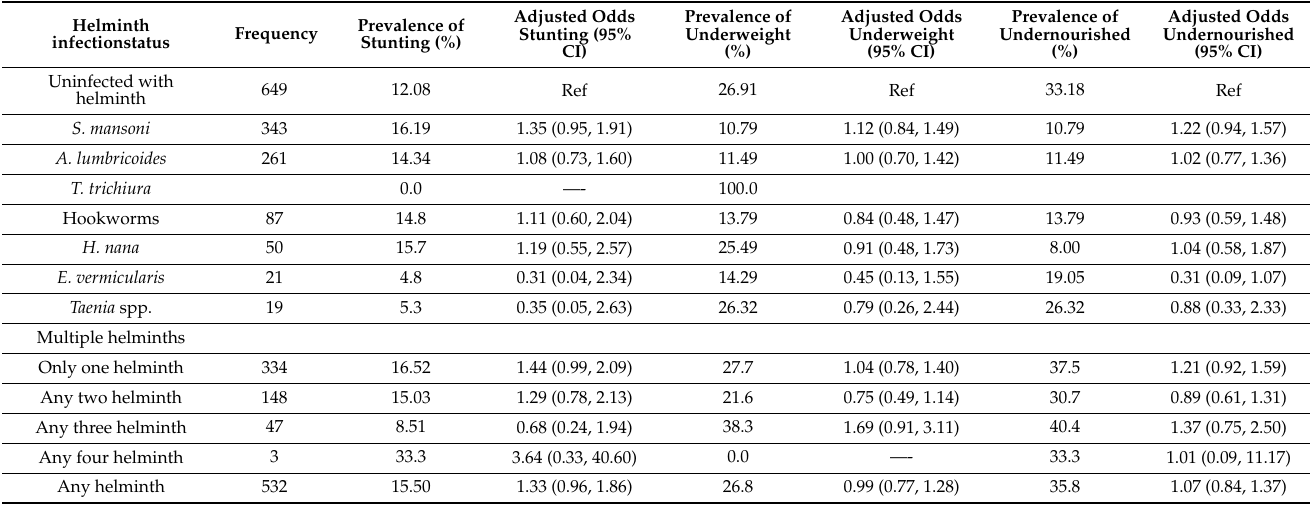
Table 4. Helminth infection status and nutritional status among school children in Maksegnit from May to July 2021 (N = 1205).